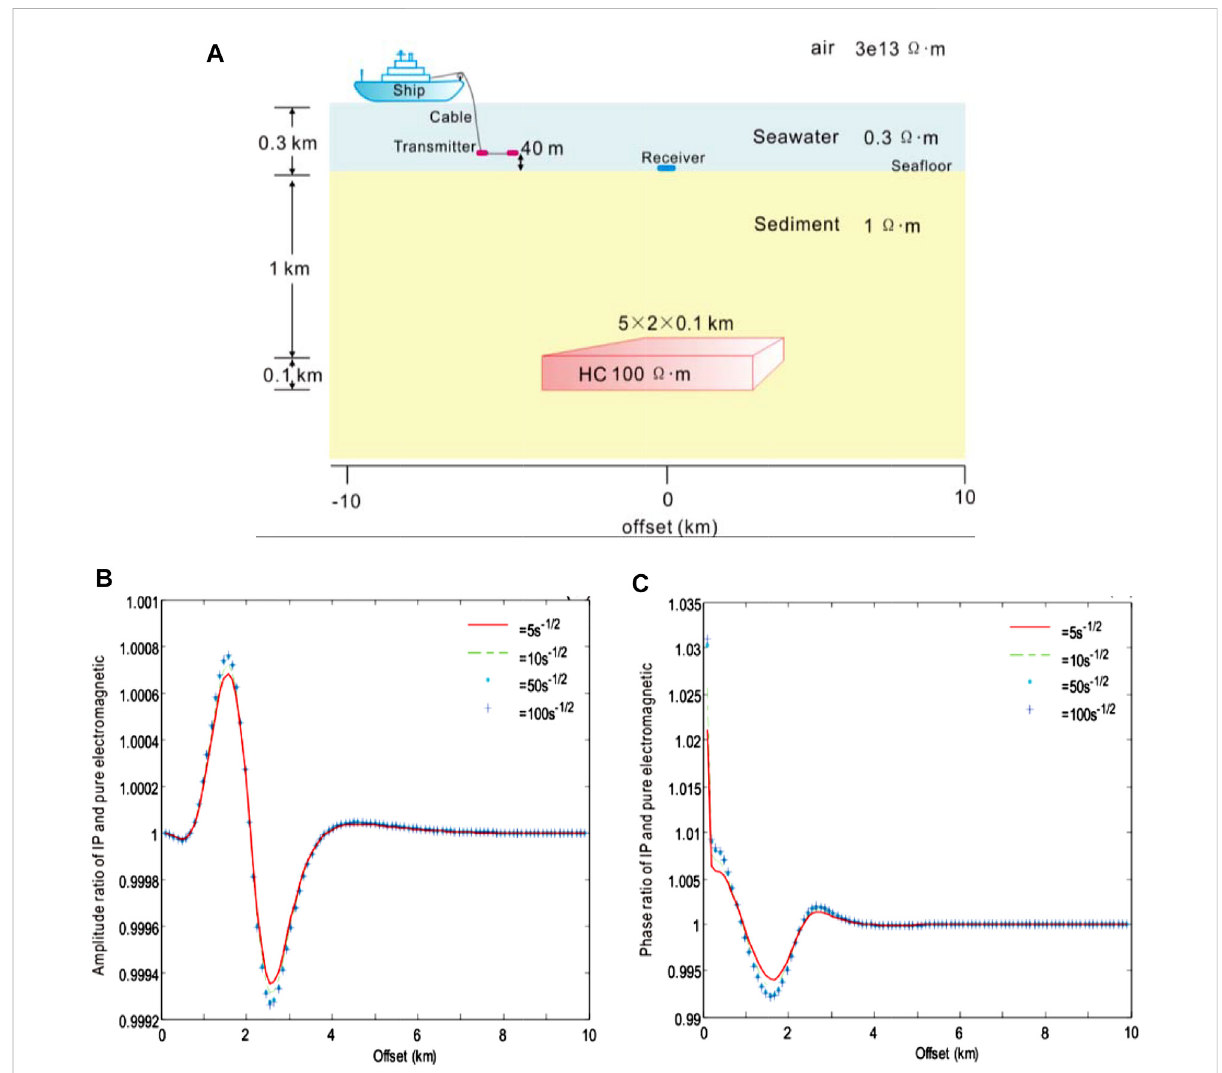
FIGURE 10 Amplitude and phase ratio of CSEM with the IP and pure electromagnetic fi eld to the Dias model of various electrochemical parameters η = 5 s − 1/2 (red),10 s − 1/2 (green),50 s − 1/2 (blue),and100 s − 1/2 (lightblue),respectively. (A) Geoelectricmodelofsubmarinehydrocarbonswithion-induced polarization in the 3D marine CSEM, (B) the ratio of amplitude, and (C) the ratio of